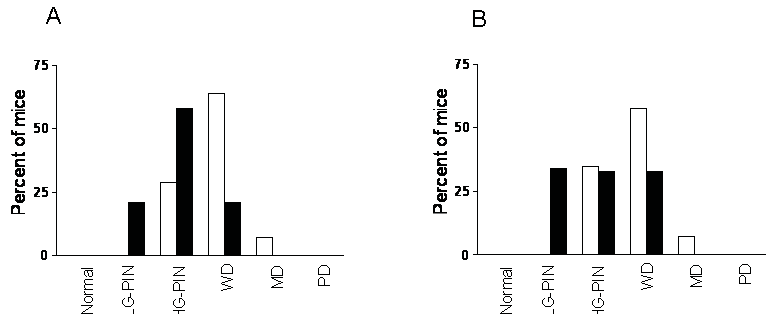
Figure 4. Effect of delayed treatment with CDDO-Me on tumor grade. Bar graphs show distribution of histologic grades (normal, LG-PIN, HG-PIN, WD, MD or PD carcinoma) in DLP (A) and VP (B) . Number of animals in each group =